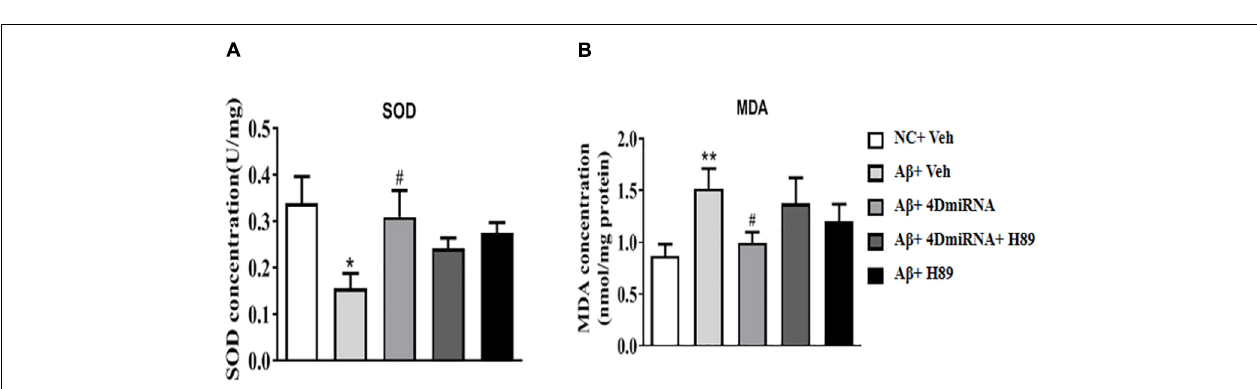
FIGURE 5 | PDE4D deficiency improved LTP (A) and increased PSD95 and synaptophysin expression (B,C) in the prefrontal cortex of A β 1–42-treated mice. Data are presented as mean ± SEM ( n = 12); values are the means ± SEM, * P < 0.05, *** p < 0.001 vs. control group (NC); # P < 0.05 vs. A β +Veh group; $ P < 0.05 vs. A β +4DmiRNA